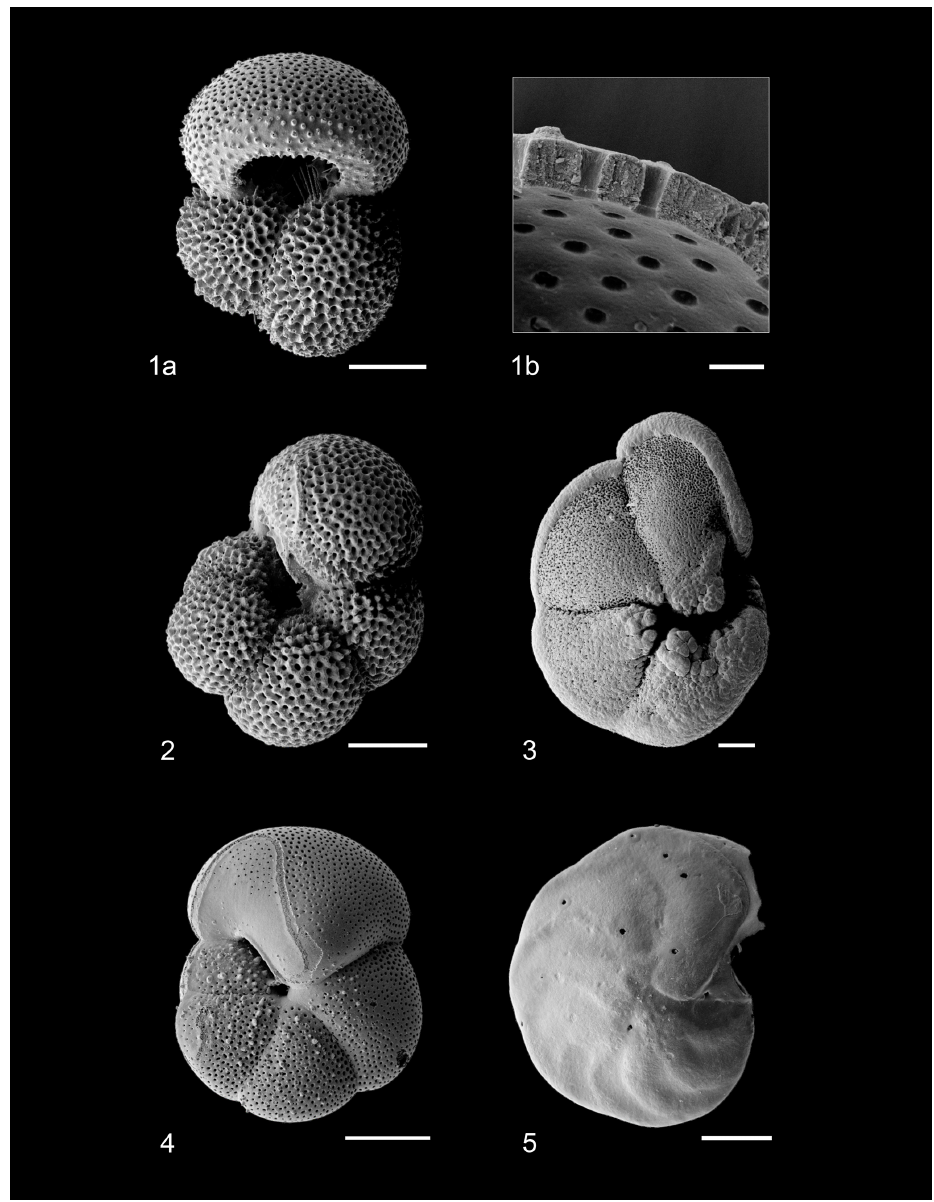
Figure 1. Scanning electron micrographs of species analyzed for stable isotope geochemistry. (1a) G. ruber , (1b) G. ruber shell ultrastructure showing excellent preservation, (2) N. incompta , (3) G. tumida , (4) H. scitula , (5) C. wuellerstorfi . Scale bar for images (1a) , 2–5 = 100µm, for image (1b) = 10µm. All specimens from sample